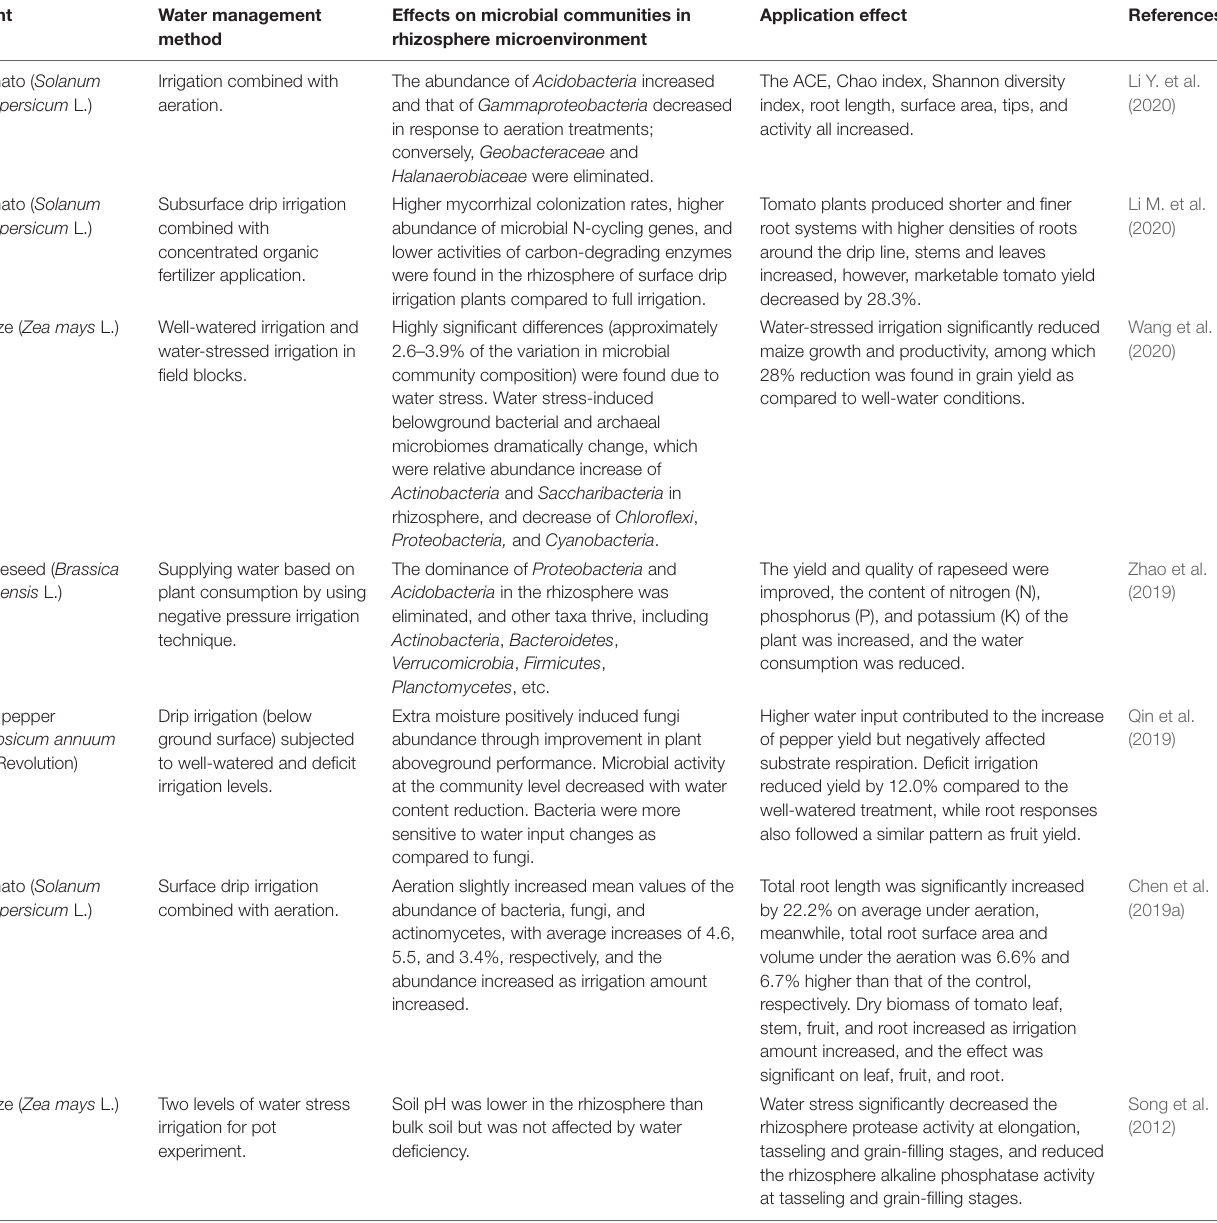
TABLE 1 | Cases of water management, using CEA systems or controlled agricultural techniques to explore the impact of the microbiome on